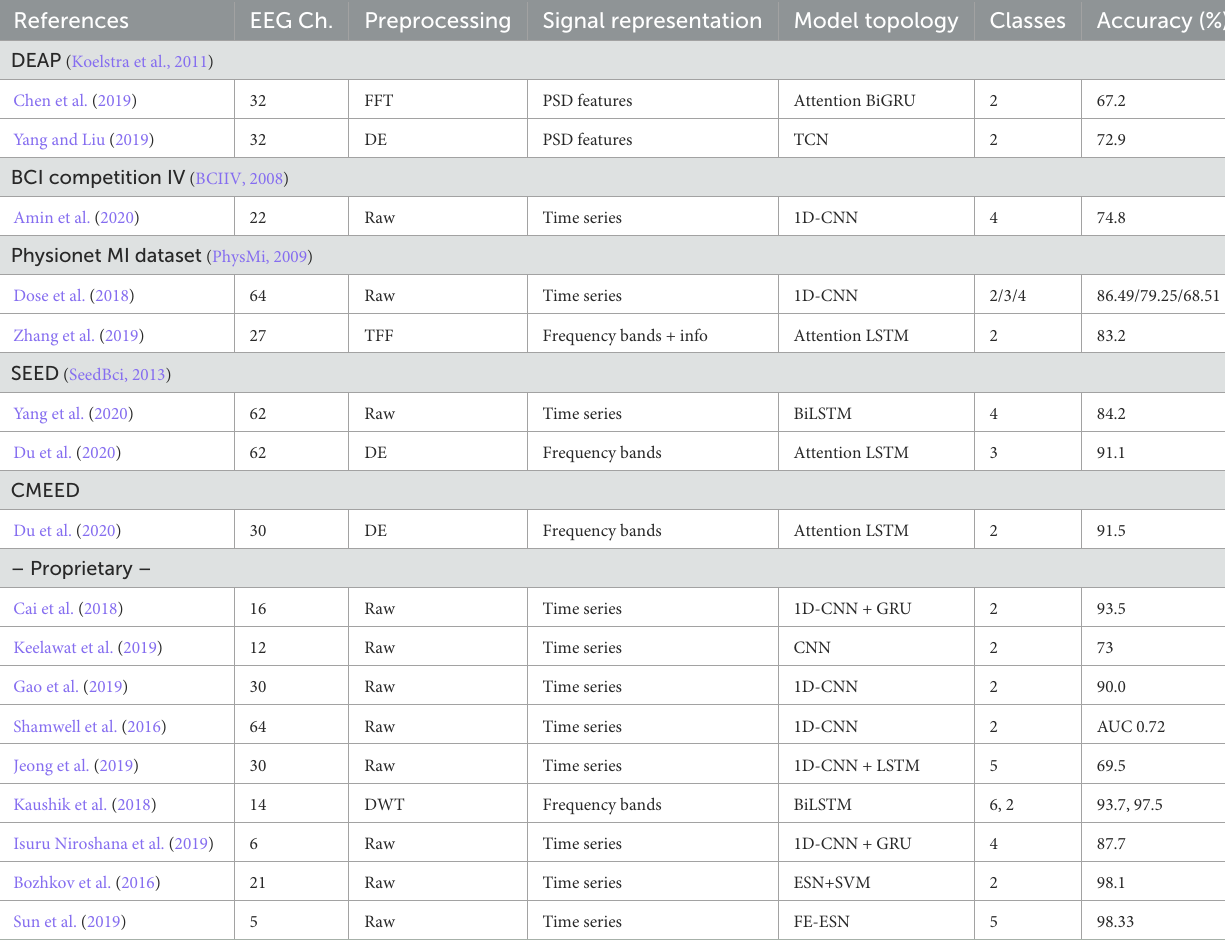
TABLE 4 Previously studied deep learning EEG analysis methods grouped by